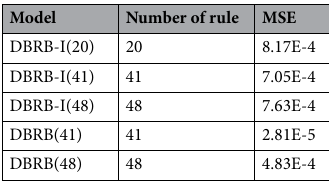
Table 6. Comparison of model accuracy.